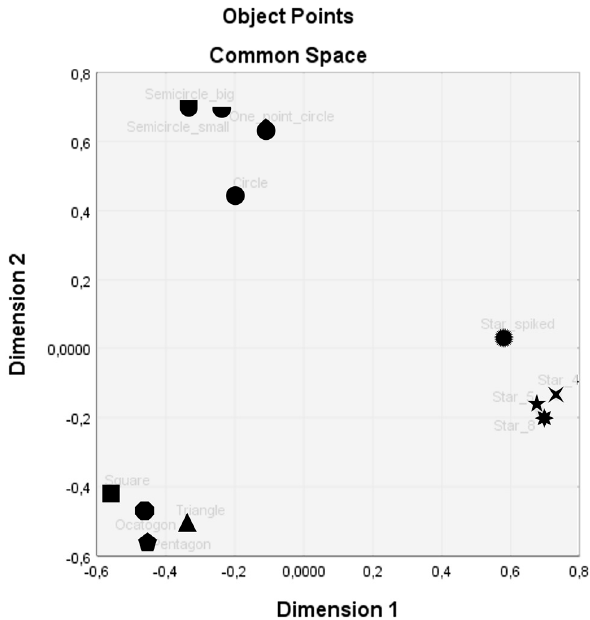
Figure 4. Two-dimensional configuration of 12 geometric shapes using MDS.